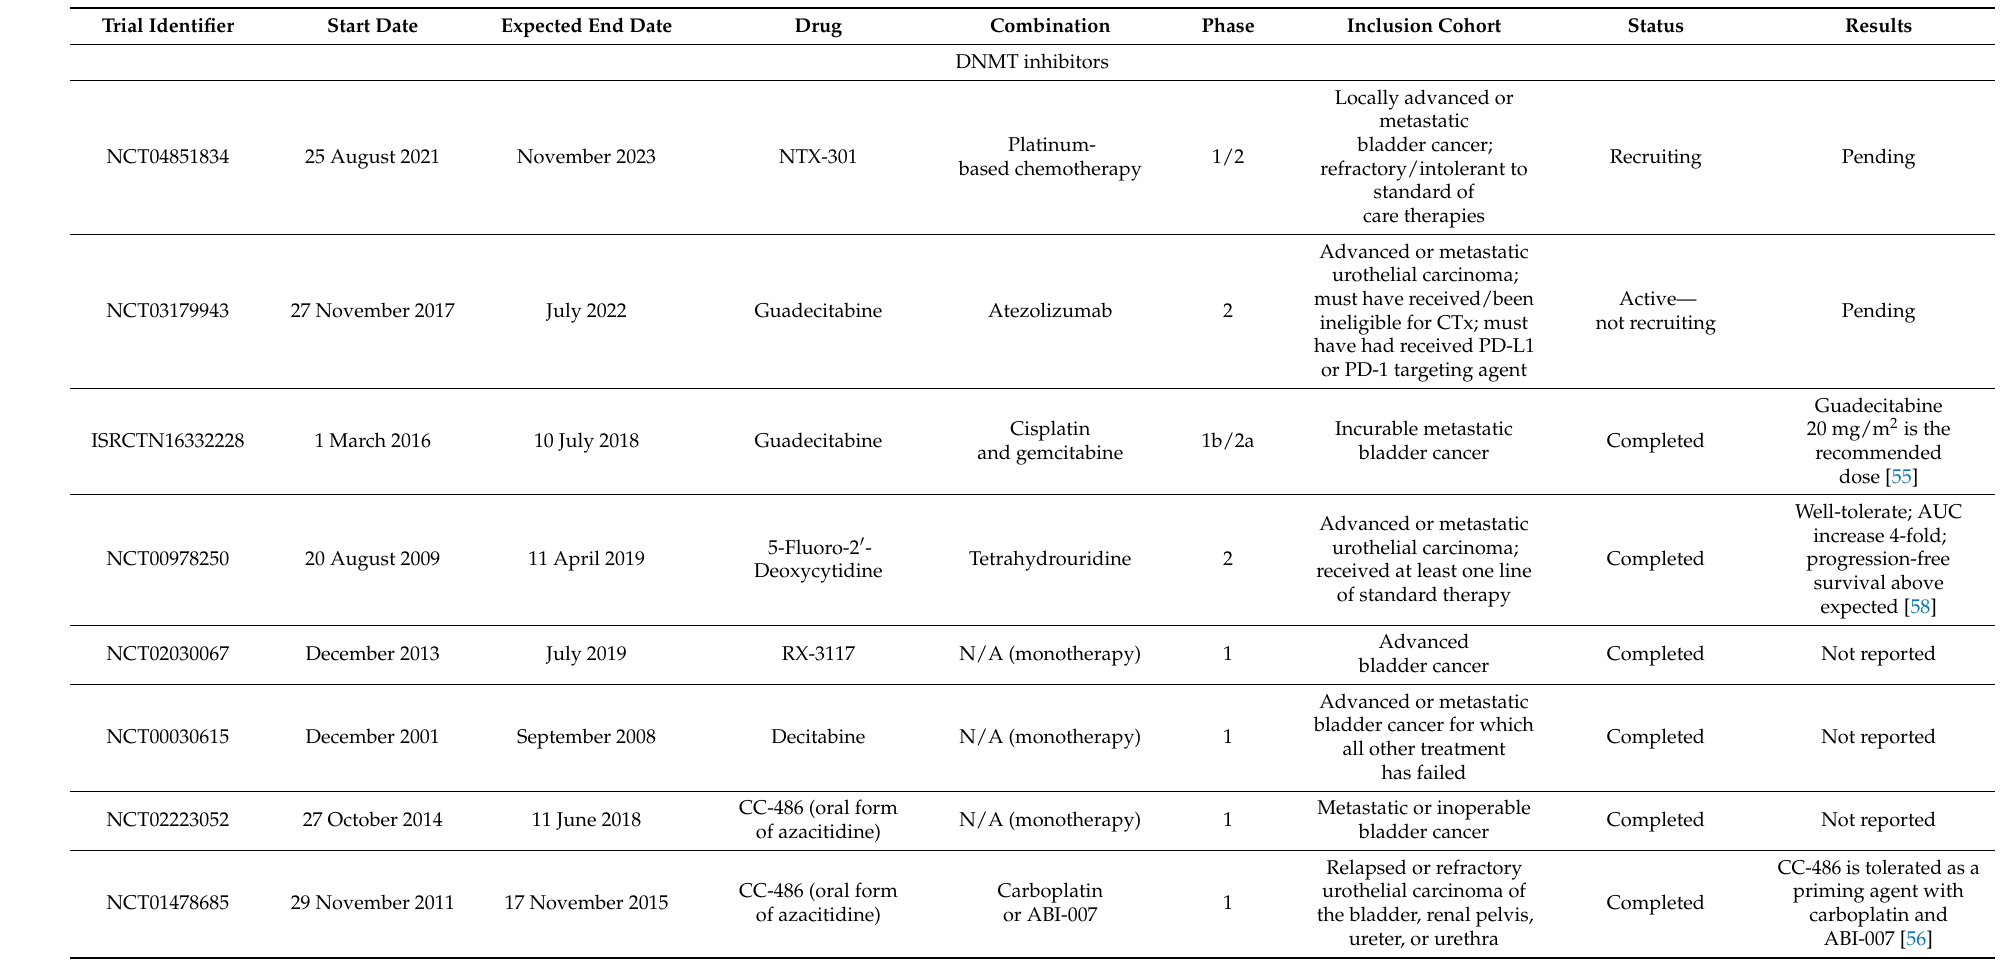
Table 1. Summary of current human clinical trials investigating epigenetic inhibitors in bladder